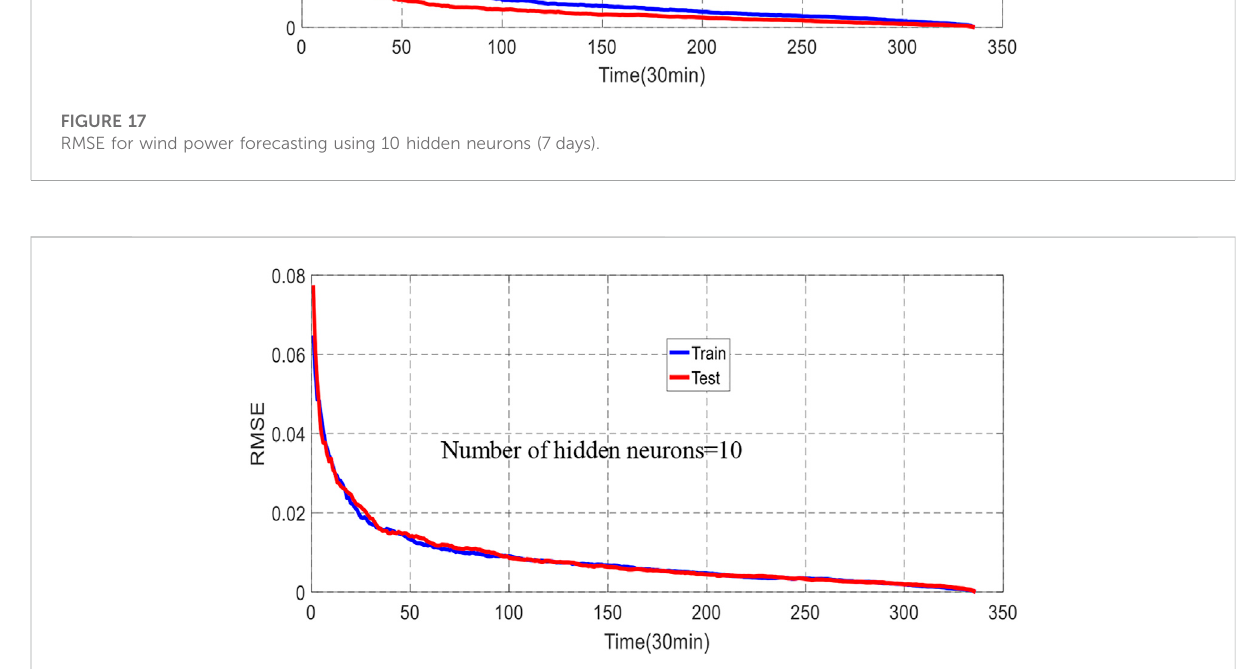
FIGURE 18 RMSE for load demand forecasting using 10 hidden neurons (7 days).